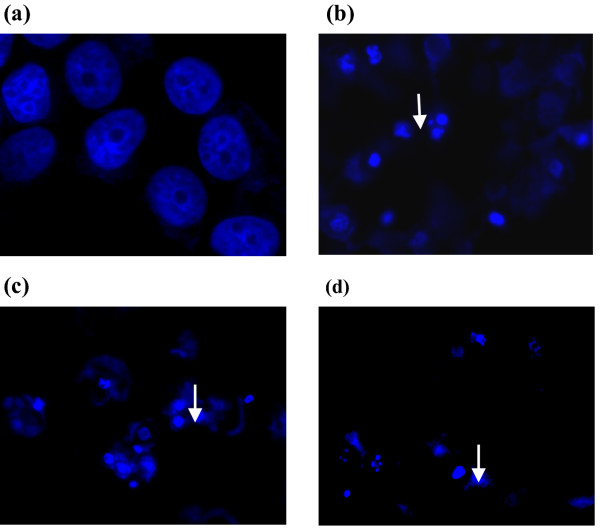
Apoptosis induced by bis-aziridinylnapthoquinone (AZ-1) in MCF-7 cells. The MCF-7 cells were treated in 24-hour culture with (a) dimethylsulfoxide control, (b) 0.2 μM AZ-1, (c) 1.0 μM AZ-1, or (d) 2.0 μM AZ-1 before Hoechst staining and analysis of the DNA nuclei. Apoptotic cells showed blue, peripherally clumped or fragmented chromatin as indicated by the arrows.